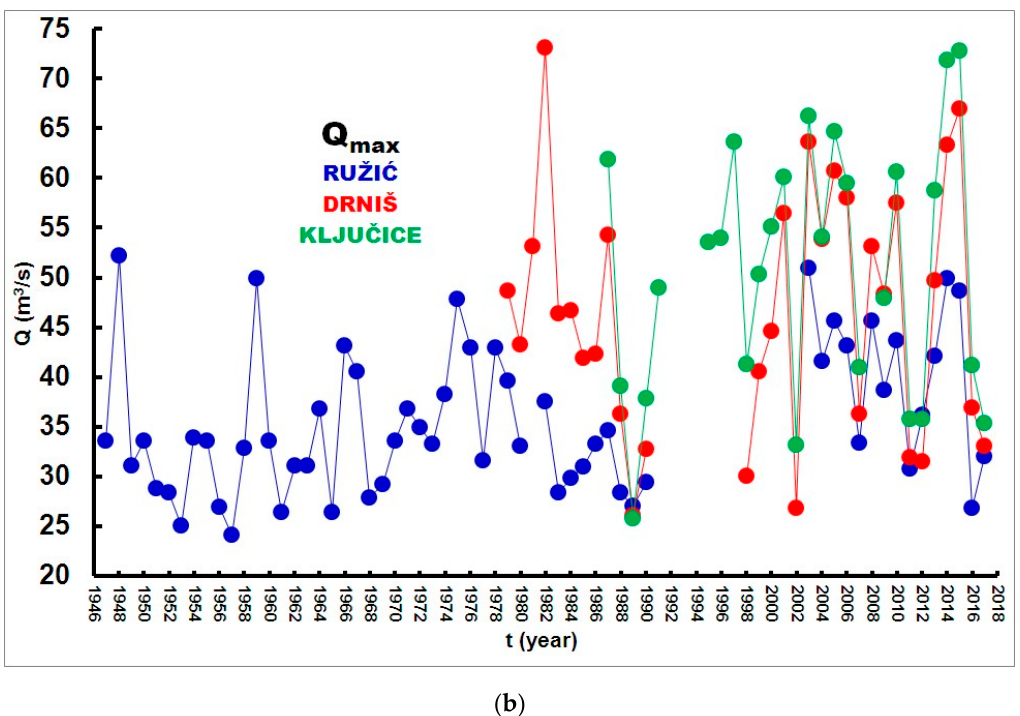
Figure 6. Time series of the mean annual discharges ( a ) and maximum annual discharges ( b ) measured at the three hydrological stations along the Č ikola River course: (1) Ruži ć